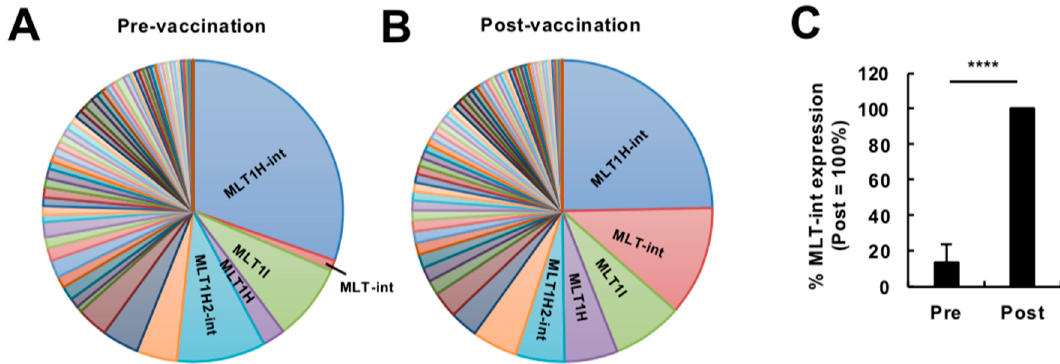
Figure 1. Expression profiling of transcripts containing retroelements in the human blood during vaccination at a high dose. ( A , B ) Diversity of transcripts containing the mammalian apparent LTR-retrotransposon (MaLR) elements expressed in peripheral blood cells before ( A ) and at 24 h after ( B ) vaccination at a high dose (GSE98212, high-dose, N = 10). The vaccination was administered to humans in a previous study using a replication-defective simian adenovirus expressing two Leishmania proteins, KMP-11 and HASPB, at a high dose (for more detail, see Reference [6]). The top five elements are indicated. ( C ) Expression of MLT-int-containing transcripts before (Pre) and after (Post) vaccination. The percentage of MLT-int expression (reads per kilobase of exon per million mapped reads, RPKM) before vaccination to that after vaccination for each subject was calculated. The values are expressed as the mean ± SD; **** p < 0.001.